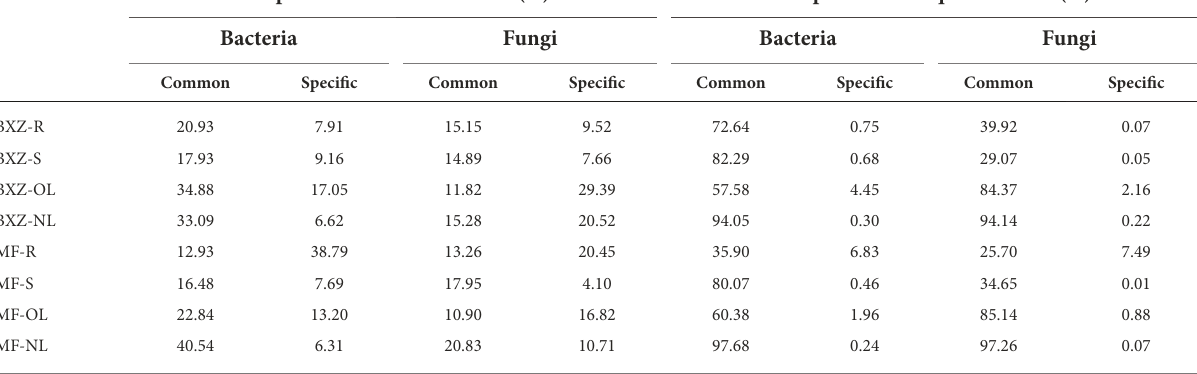
TABLE 1 Proportions of common and specific taxa in total OTU numbers and population sizes of endophytic bacteria and fungi in tea trees.